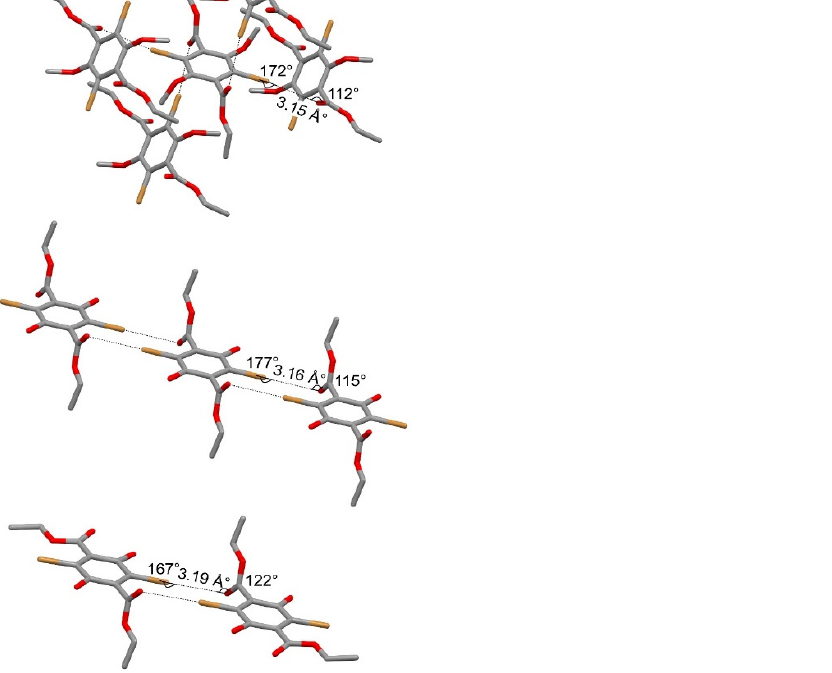
Figure 4. Simplified sketches of the supramolecular C ar -Br · · · O carbonyl XB interactions (drawn as dashed lines) in the terephthalate-based compound 4a , carrying two methoxy substituents on the aromatic ring ( top ), and in two polymorphic forms of diethyl 2,5-dibromo-3,6-dihydroxyterephthalate, carrying two hydroxy substituents: the form occurring in an ethanol solvate crystal ( middle ) and the form II ( bottom ). The XB motif on the top originates a supramolecular sheet, the one on the middle originates a supramolecular chain, the one on the bottom originates a supramolecular dimer.